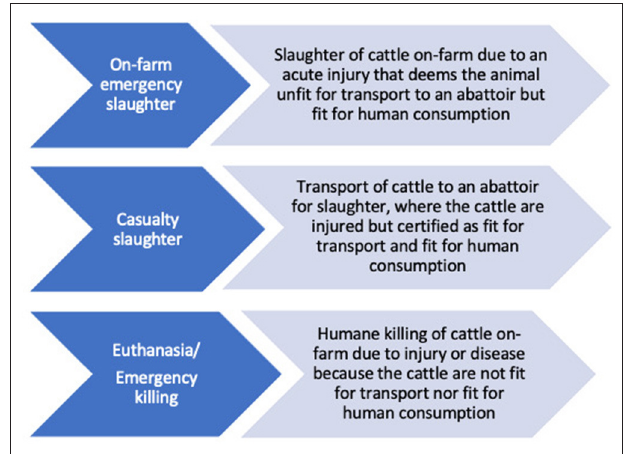
FIGURE 1 | Definitions of procedures for slaughter of injured